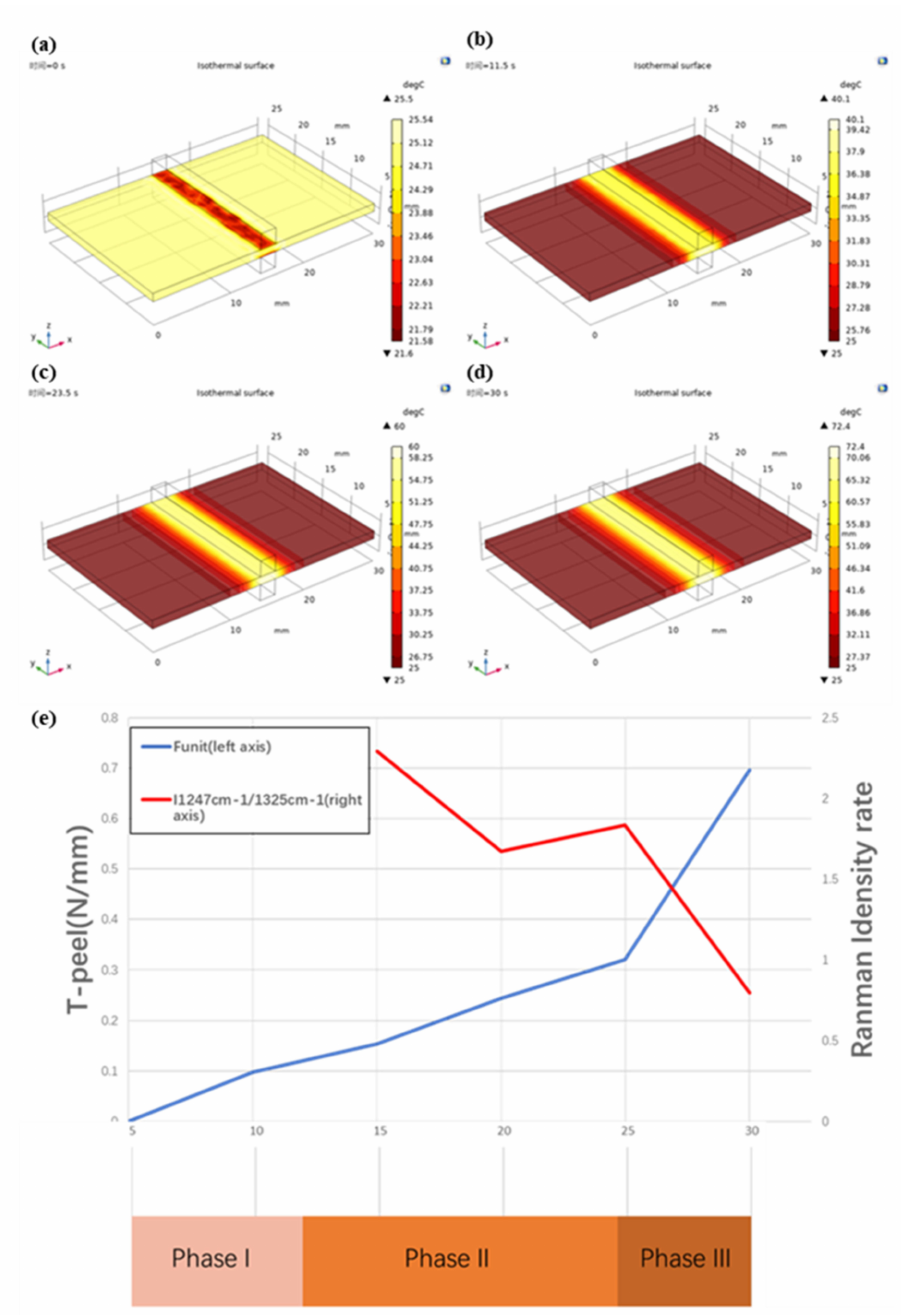
Figure 9. T-peel data and Raman Spectrum data at different phases. ( a ): At the beginning of the welding experiment(t = 0 s), the initial temperature of vessel tissue is about 25 ◦ C The central area of the vessel is fixed by a low − temperature (about 20 ◦ C) metal electrode, and the temperature is reduced. ( b ): When the welding time is 11.5 s, the temperature in the central area of vessel tissue reaches 40 ◦ C and spreads to both sides. ( c ): When the welding time is 23.5 s, the temperature in the central area of vessel tissue reaches 60 ◦ C and spreads to both sides. ( d ): When the welding time is 30 s, the highest temperature of vessel tissue reaches 72.4 ◦ C. ( e ): The left axis coordinates of the line chart represent the T − peel test strength, the right axis represents the ratio of I1247 cm − 1 /I1325 cm − 1 and the horizontal axis coordinates represent the welding time. Phase I: 0 − 11.5 s, Phase II: 11.5 − 23.5 s, Phase III: 23.5 − 30